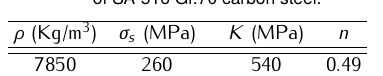
Table 2. Physical and mechanical properties of SA-516 Gr.70 carbon steel.